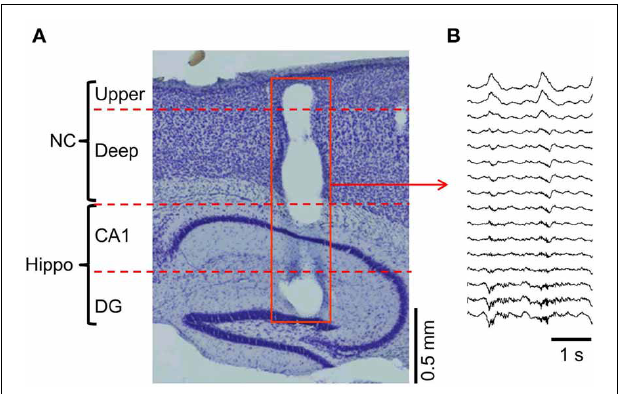
FIGURE 1 | Multi-channel probe positions and LFP recordings. (A) The multi-channel probe was positioned across the cortico-hippocampal area (NC, neocortex; upper, upper layers; deep, deep layers; CA1, hippocampal area around the Cornu Ammonis areas; DG, hippocampal area around the dentate gyrus). The hole on the sagittal section (red square) shows the position of the probe. (B) The temporal profile example of the LFP recorded from the probe in (A)